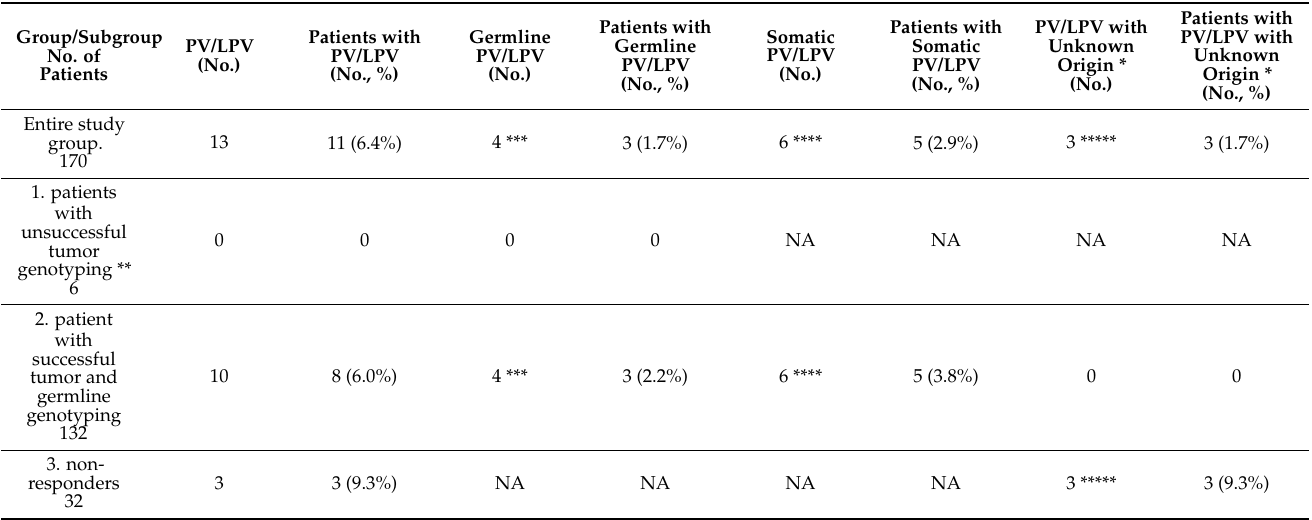
Table 3. Pathogenic/likely pathogenic variants (PV/LPV) in nonBRCA HBOC genes among all 170 consecutive advanced non-mucinous EOC